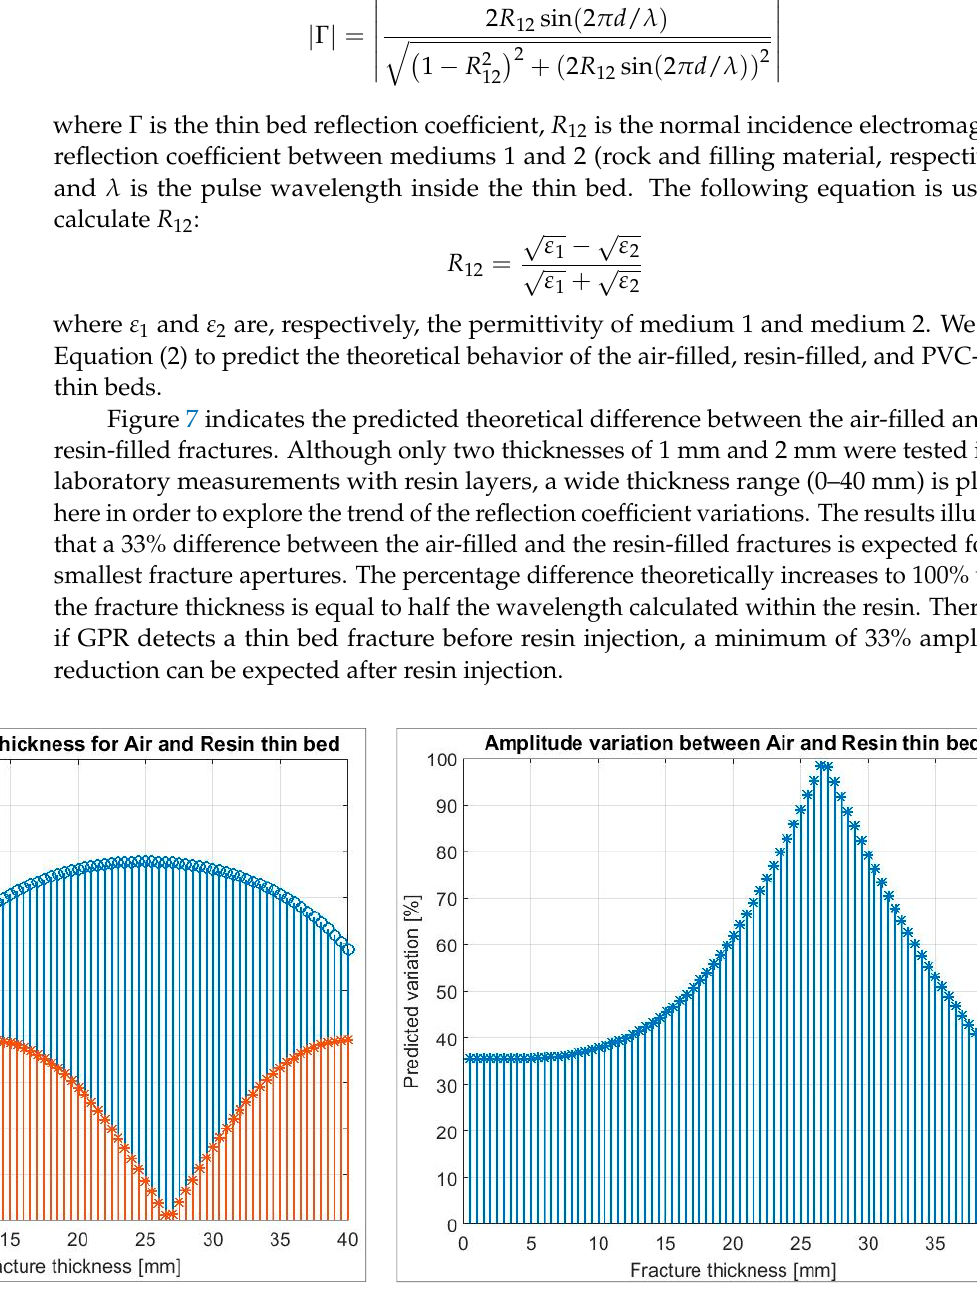
Figure 8. Comparing the predicted amplitudes for the air-filled fractures versus the PVC-filled frac- tures with a 3 GHz antenna. Circles: air data, stars: PVC data. 3. Results and Discussion The laboratory data were processed by using the ReflexW software, but the ampli- tude picking was performed manually. To prevent the influence of any DC or very low